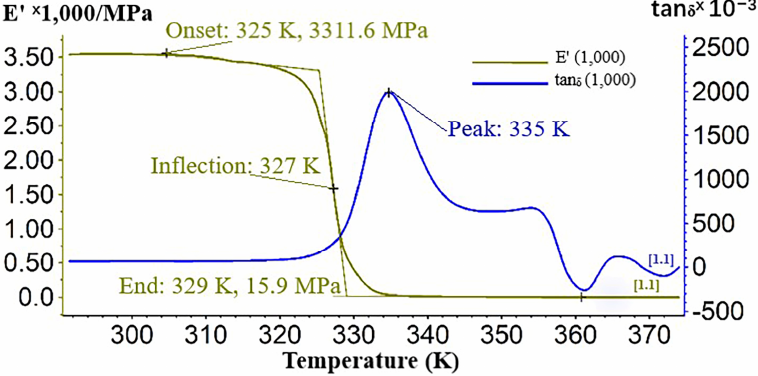
Figure 6. Dynamic Mechanical Analysis (DMA) thermogram recorded during heating of Extrudr BDP Flax.